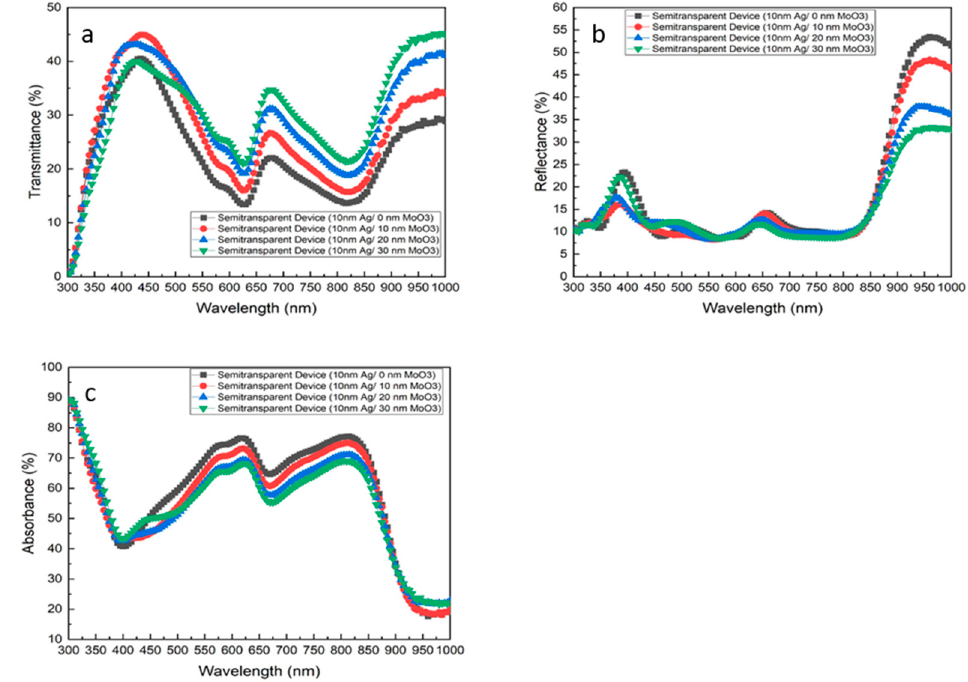
Figure 3. ( a ) Transmittance, ( b ) reflectance and ( c ) absorbance spectra of the semi-transparent devices over different outer MoO 3 layer thicknesses.